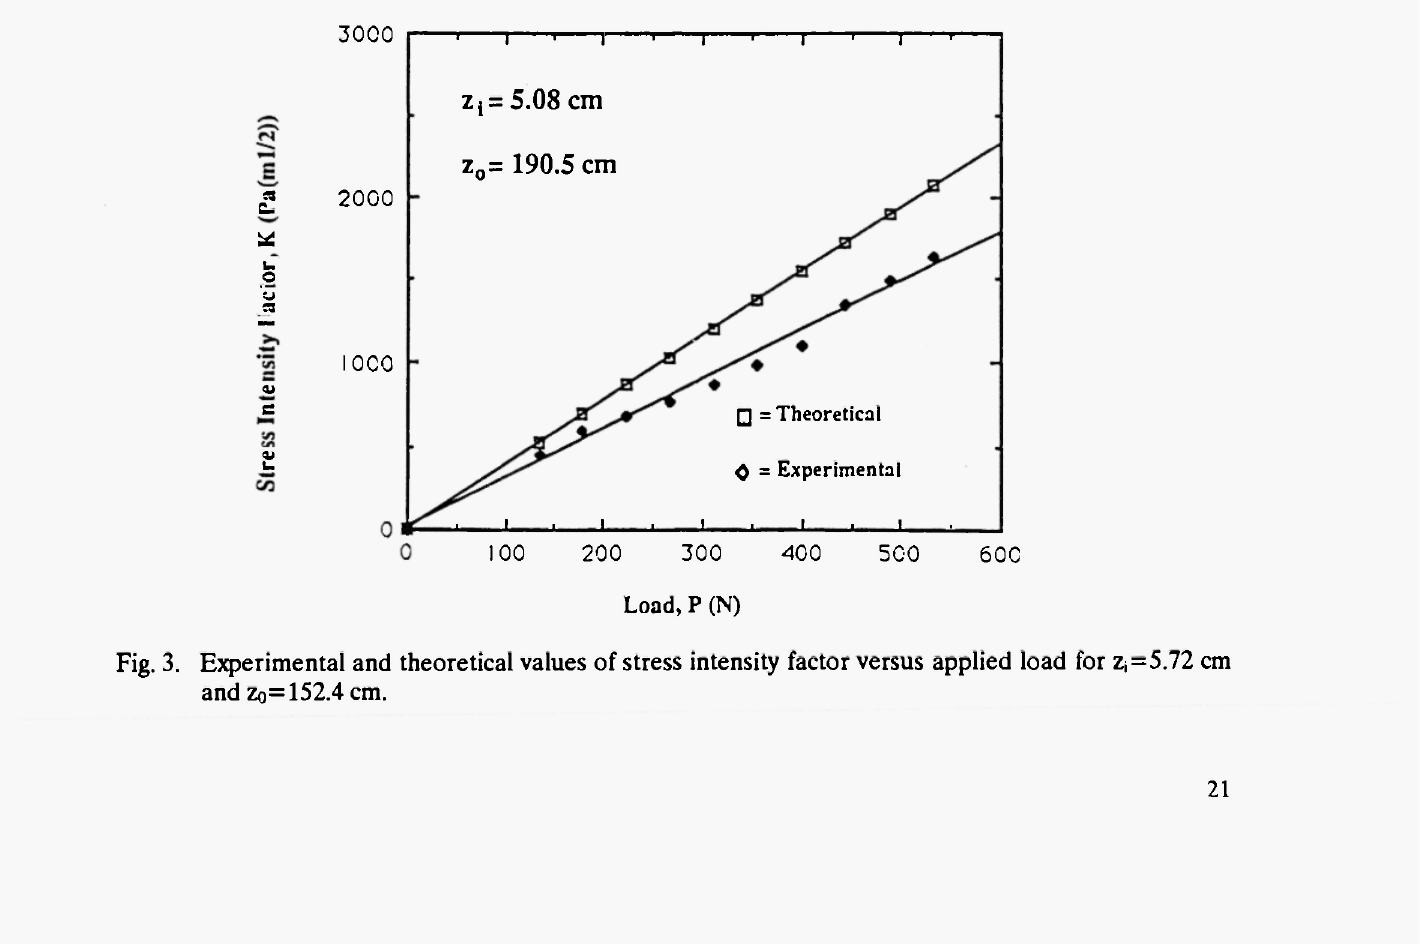
Fig. 2. Experimental and theoretical values of stress intensity factor versus applied load for Zi =5.72 cm and Z q=101.6 cm.